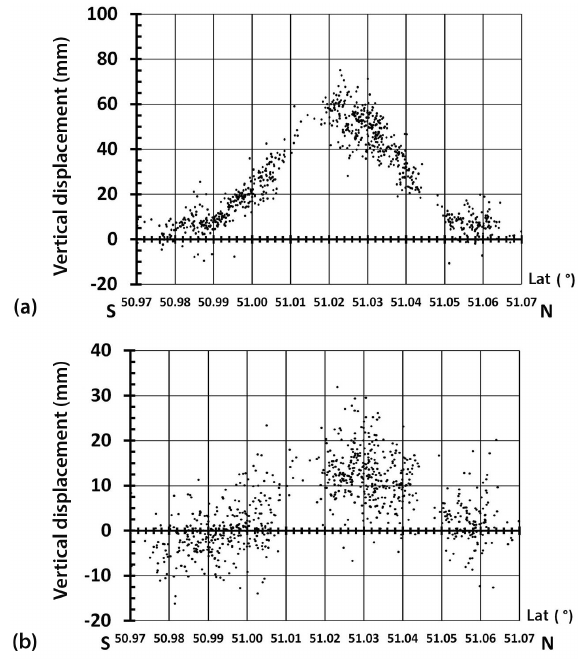
Figure 7. Variation of the total surface movement along a north– south transect, situated for a longitude between 5.37 and 5.38 ◦ E: (a) period 2, 5-year time zone, from mid-September 2005 through mid-September 2010; (b) period 2, 2.5-year time zone, from De- cember 2003 through June 2006.